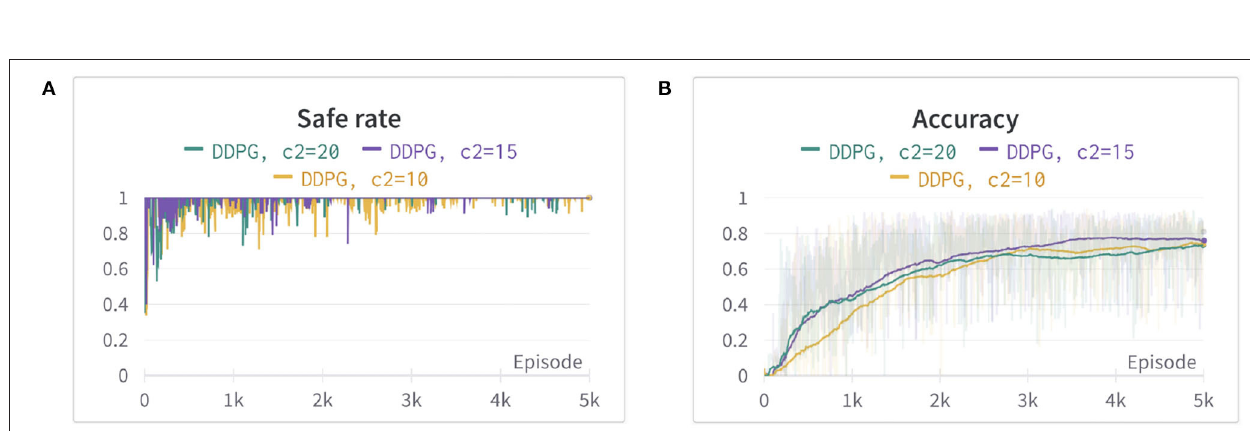
FIGURE 3 | The comparison between different weights of reward R O . (A) The safe rate (defined in Section 4.2) of three different weights of reward R O . (B) The accuracy (defined in Section 4.2) of three different weights of reward R O using an exponential moving average for better visualization. The two figures show that c 2 = 15 has better learning efficiency, safe rate, and